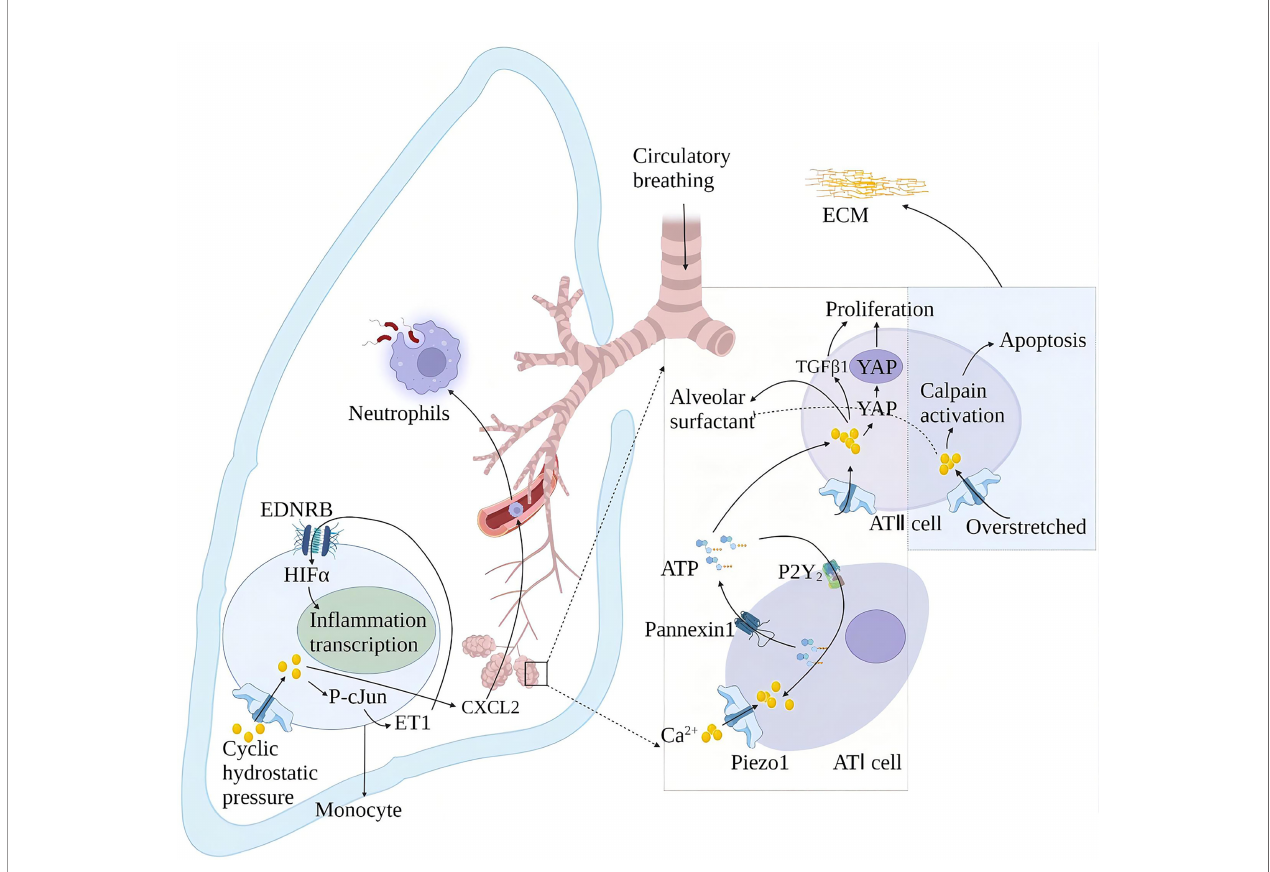
FIGURE 7 | Schematic diagram of the role of Piezo1 in innate lung immunity and pulmonary fi brosis. Periodic hydrostatic pressure in the lungs can activate monocyte Piezo1 to cause Ca 2+ in fl ux, phosphorylation of transcription factor cJun, and expression of endothelin 1 (ET1), which in turn activates HIF1 a via the endothelin receptor type B (EDNRB), Thereby promoting the transcription of pro-in fl ammatory mediator programs. Piezo1 also increased the secretion of the chemokine CXCL2 in monocytes in the lung, inducing neutrophils to migrate from the blood vessels to the lungs to clear bacteria. Piezo1 senses alveolar tone and is involved in the secretion of alveolar surfactant and proliferation of ATII. Alveolar hyperextension leads to reduced secretion of alveolar surfactant and apoptosis of ATII, exacerbating lung injury and in fl ammation in ARDS patients. Piezo1 upregulation in alveoli induces an epithelial-mesenchymal transition with increased extracellular matrix (ECM) stiffness and promotes pulmonary fi